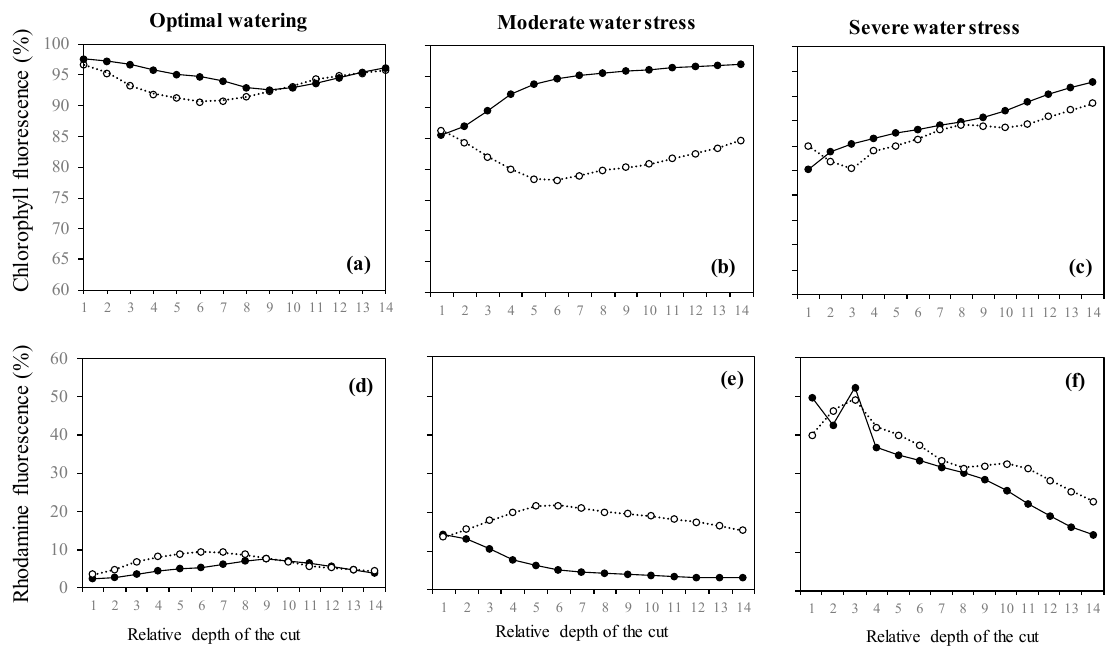
Figure 3. ( a–c ) Intensities of chlorophyll fluorescence and ( d–f ) intensities of rhodamine fluorescence (denoting H 2 O 2 presence) from leaves of Acer monspessulanum across 14 leaf cuts carried out through laser penetration. Values are mean with n = 3 ( n : number of saplings).